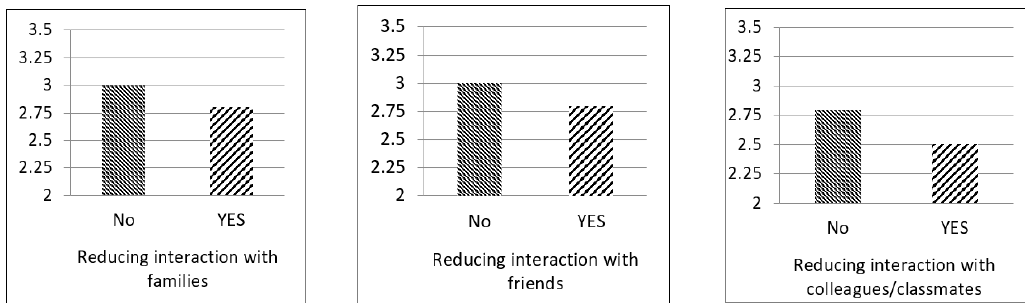
Figure 1. Levels of Perceived Social Support in the Participants with and Without Reduction of Social Interaction. Table 2. Association Between the Reduction of Social Interaction and Perceived Social Support: Multiple Regression Analysis. Variables